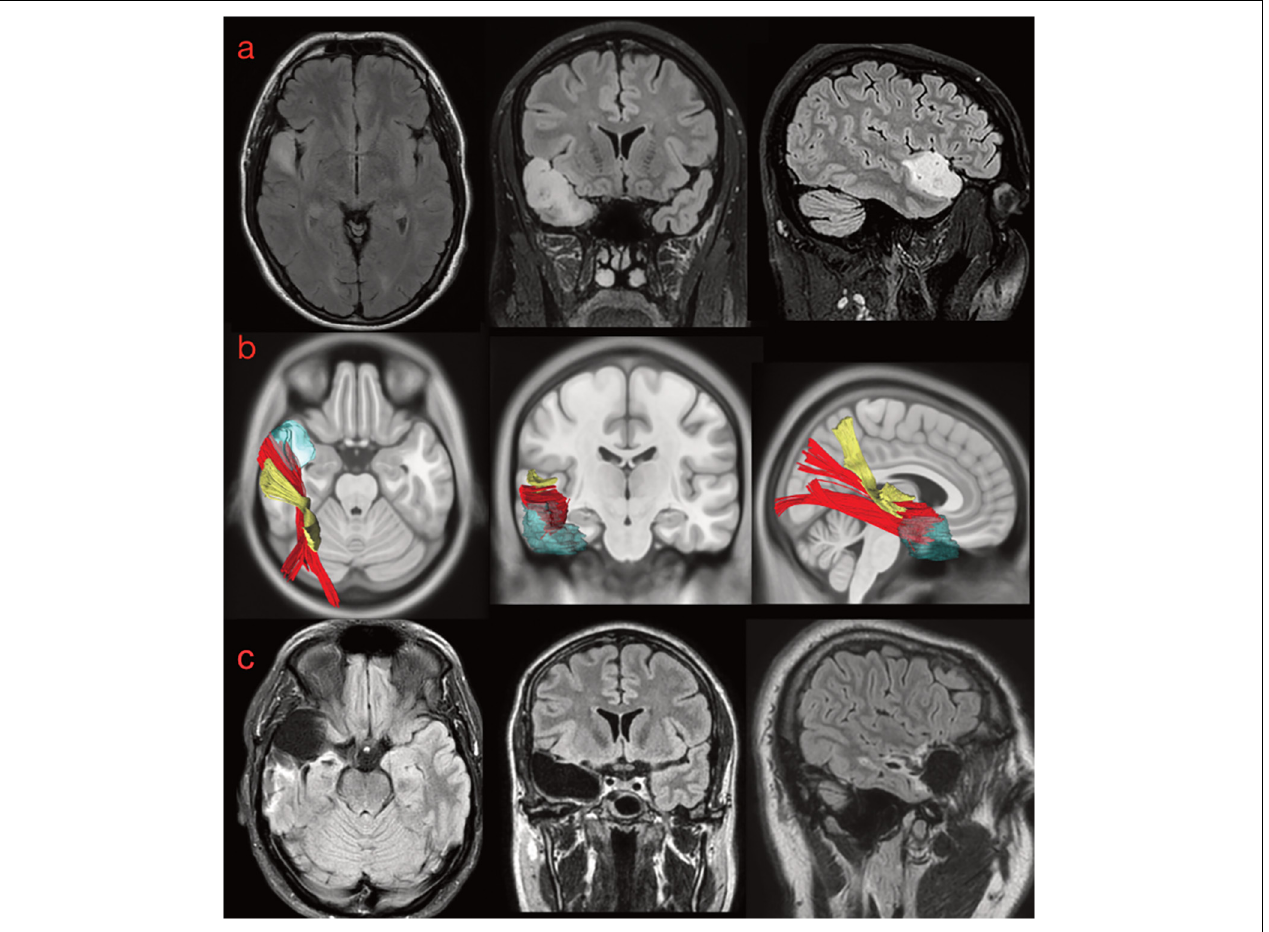
FIGURE 10 | (a) Preoperative morphological MRI T2-Flair sequences of illustrative case #1. The hyperintensity signal on axial, coronal, and sagittal (first row) views show a suspected low-grade glioma involving the anterior and superior portion of the superior temporal gyrus on the right side. The tumor invaded even the medial component of the temporal pole (on the coronal). (b) The normalization of the tumor lesion volume within the MNI space allowed us to merge our anatomical results on the MdLF dissection with the patient-specific anatomy. According to our results, the tumor invaded the aMdLF (red) but not the pMdLF (yellow). (c) Postoperative MRI T2-Flair images showing a complete resection of the tumor